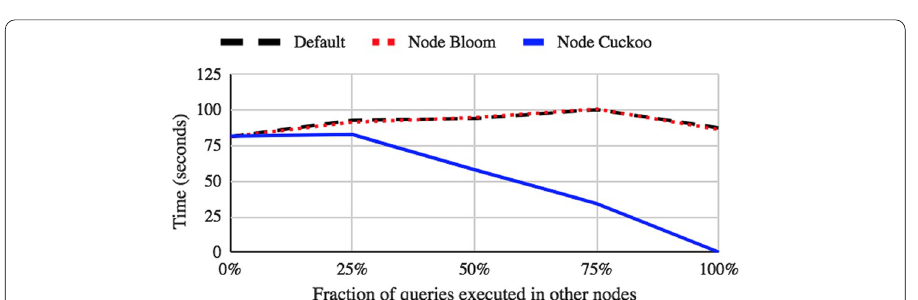
Fig. 11 Lookup performance after data deletion, by varying fraction of queries retrieving rows from remote node (lower is better). All the queries result in deleted data. Node Cuckoo Filter improves lookup performance for up to 100%, depending on the fraction of queries executed in other nodes. The performances of the default implementation and Node Bloom are very similar and hence